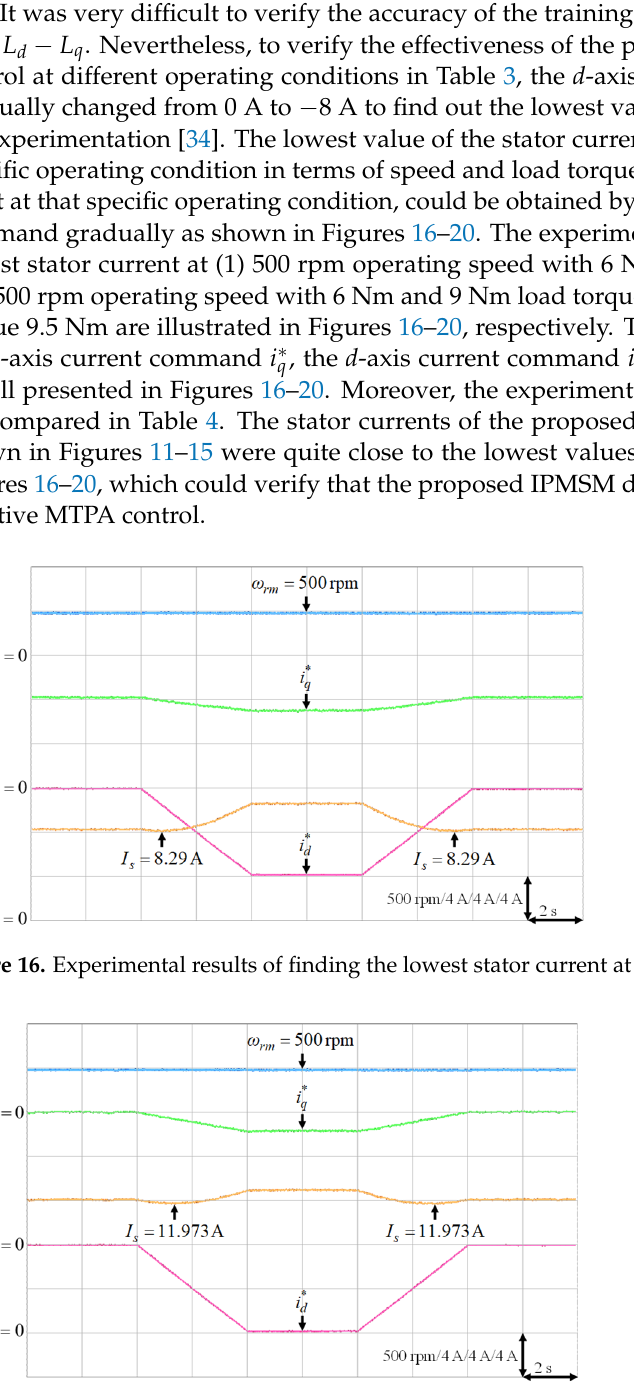
Figure 17. Experimental results of finding the lowest stator current at 500 rpm with 9 Nm.